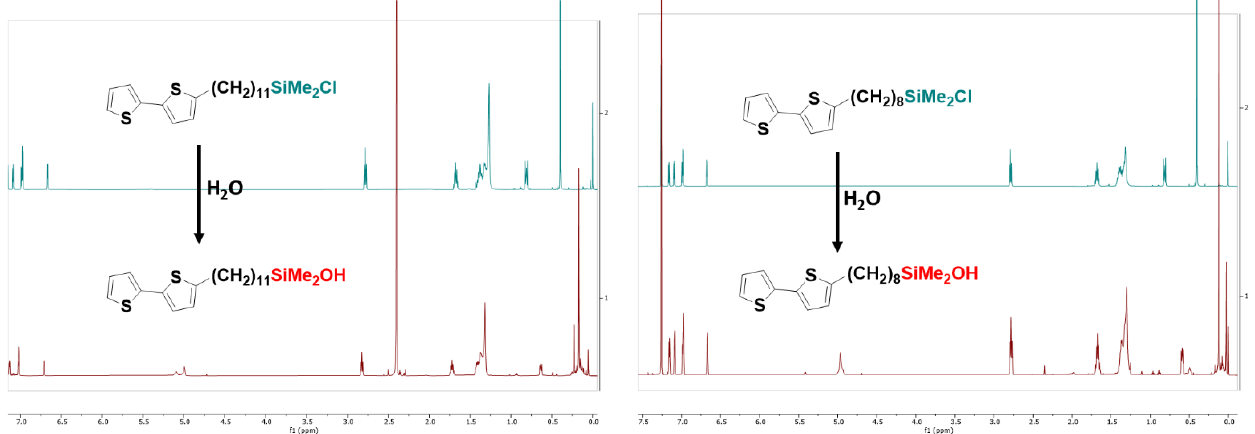
Figure 3. Changes observed in 1 H NMR spectrum of chlorodimethylsilane derivatives TTCnSi by hydrolysis.